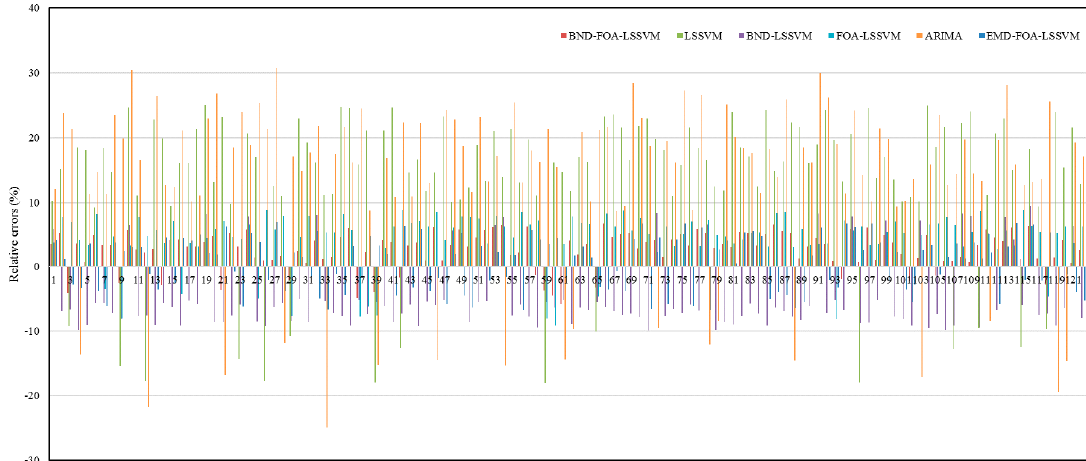
Figure 7. Relative errors of electricity price forecasting of different models (Unit: %).